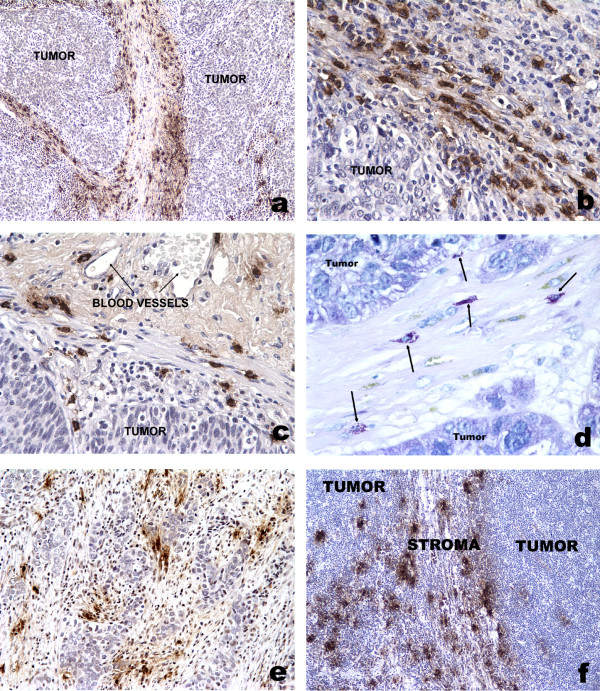
Representative photomicrographs of mast cell infiltration in human head and neck cancer (1a), lung cancer (1b, c), ovarian cancer (1d, e), and Hodgkin's disease (1f). In Figures a-c, e and f, the sections were immunostained for mast cell tryptase and revealed extensive evidence of mast cell degranulation (brown stain) in the fibrous tissue adjacent to nests of tumor cells and blood vessels. A Giemsa stain (1d) confirmed the presence of intact mast cells with dense purple granules embedded within fibrous stroma between nests of tumor cells. Hematoxylin counterstain (all figures, except 1d).